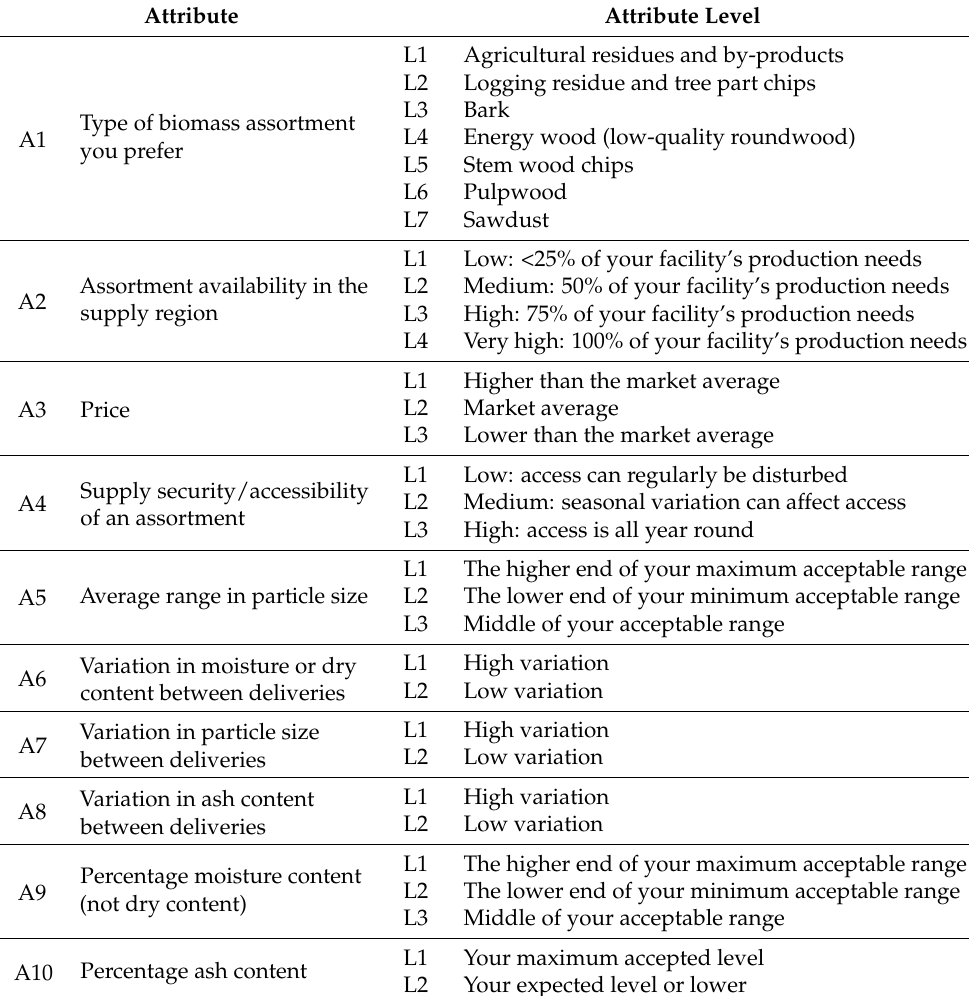
Table 1. Attributes of biomass feedstock and their associated